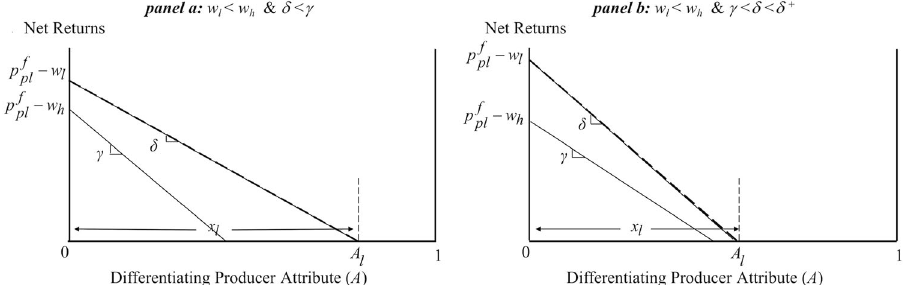
Fig. 1 Producer decisions in Scenario I. This fi gure graphs the producer net returns for the two cases that give rise to Scenario I. In both cases,